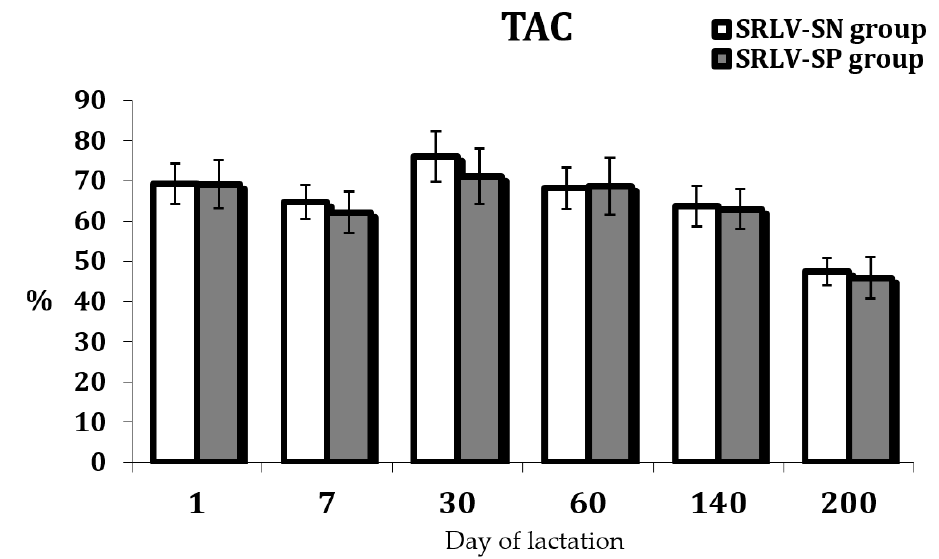
Figure 4. The total antioxidant capacity (TAC, %) in the serum of SRLV-SN and SRLV-SP goats during lactation. Values are expressed as means ± SEM; a, b—different letters indicate significant differences between stages of lactation within the SRLV-SN group at p < 0.05; a’, b’—different letters indicate significant differences between stages of lactation within the SRLV-SP group at p < 0.05; SRLV-SP—small ruminant lentivirus seropositive goats; SRLV-SN—small ruminant lentivirus seronegative goats.